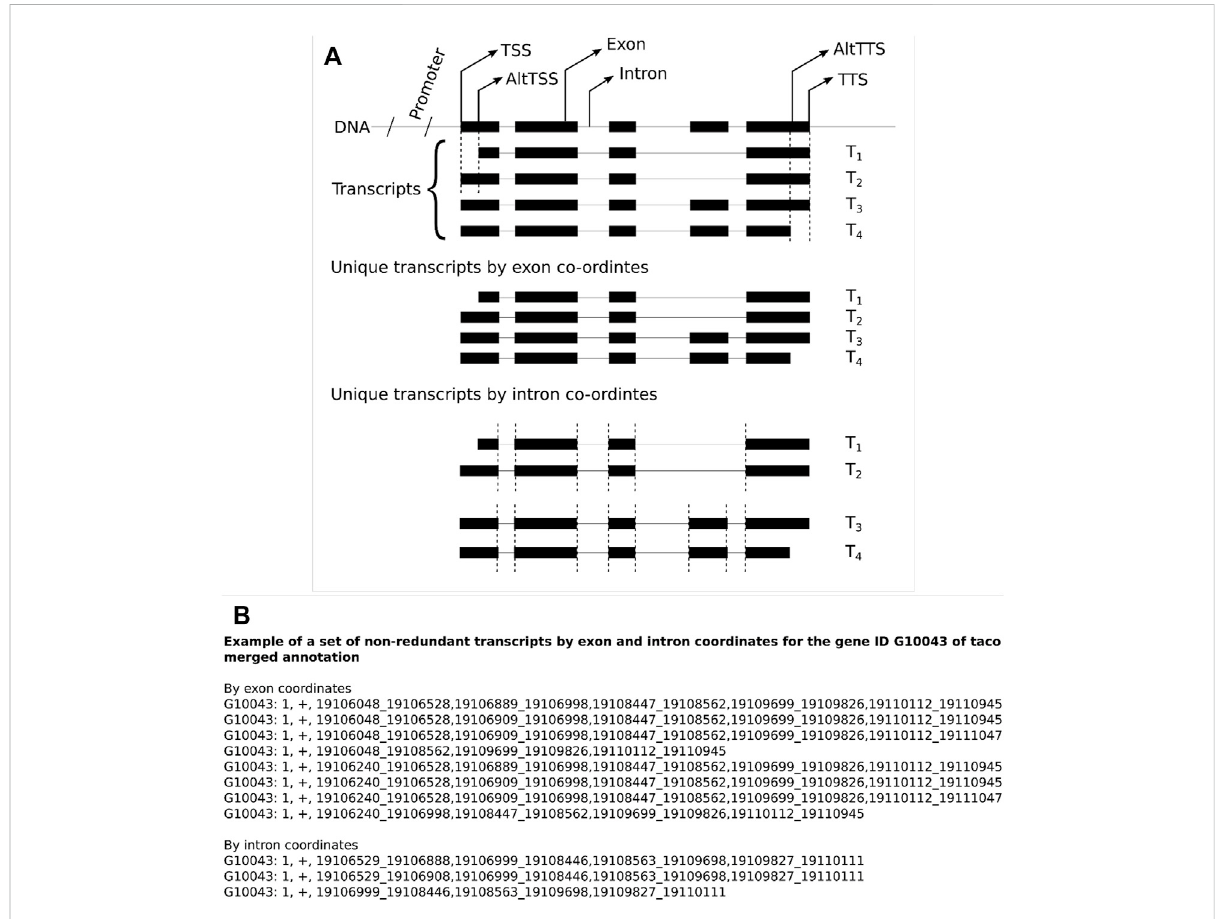
FIGURE 1 (A) Illustration of the usage of exon and intron coordinates for non-redundant transcripts to evaluate transcript GTF fi les. (B) An example set of non-redundant transcripts for the gene ID G10043 for the Taco merged annotation fi le by exon and intron